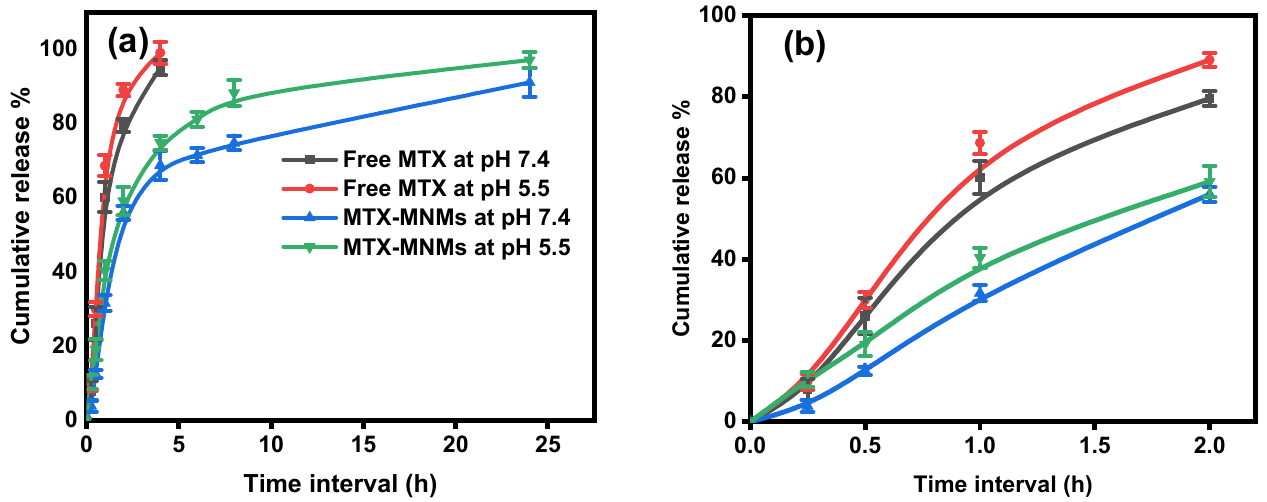
Figure 3. In vitro release profiles of the free MTX and MTX-loaded MNMs (MTX-MNMs) at two different pH values (7.4 and 5.4) for 24 h ( a ) and at the first 4 h ( b ).